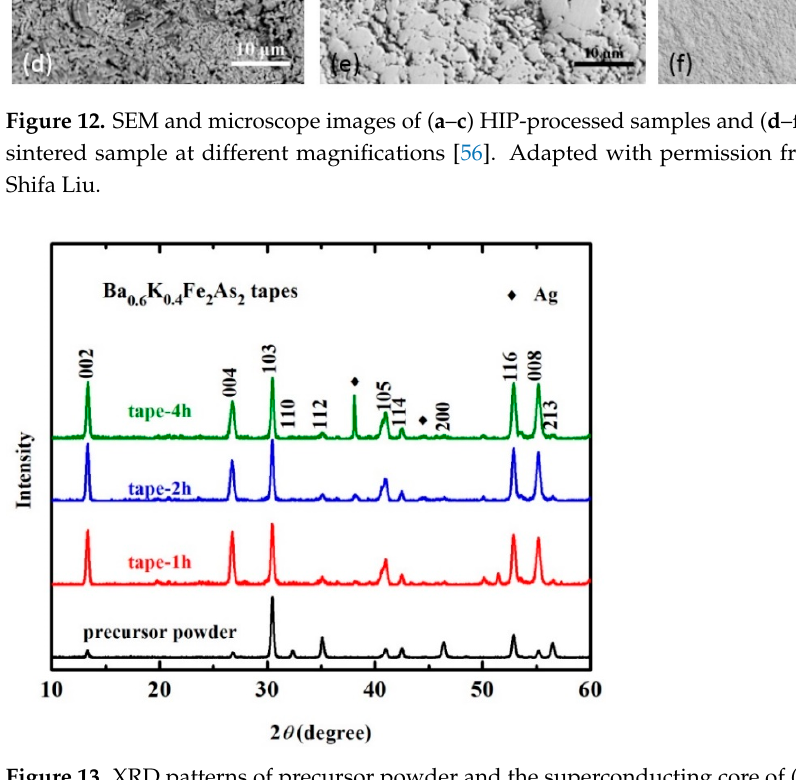
Figure 13. XRD patterns of precursor powder and the superconducting core of (Ba,K)Fe 2 As 2 super- conducting tapes with different sintering time [55]. Adapted with permission from Ref. [55]. 2019, IOP Publishing.